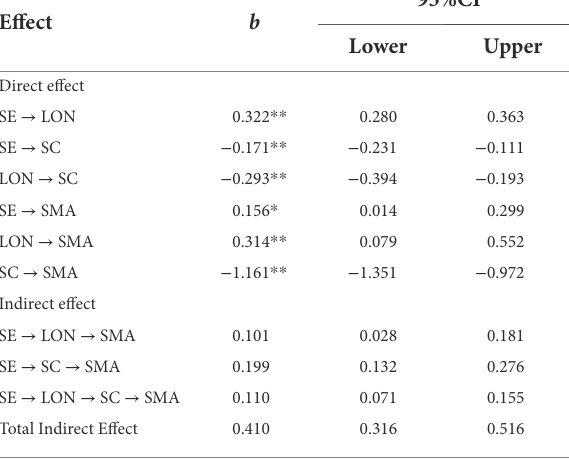
TABLE 2 Results of the sequential mediated